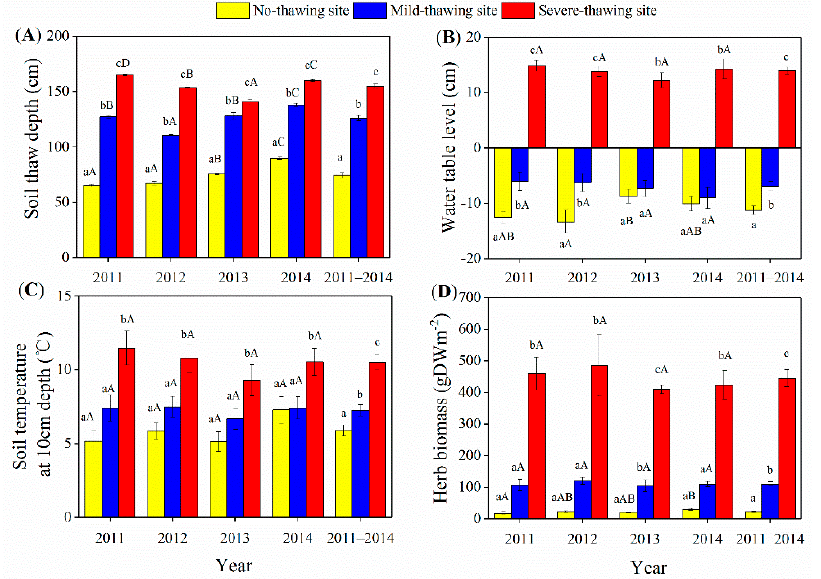
Figure 3. Differences in soil thaw depth ( A ), water table level ( B ), soil temperature ( C ) and herb biomass ( D ) among sampling years and sites. Data are means ± SE. For water table level and soil temperature, n = 18 in 2011, n = 16 in 2012, and n = 17 in 2013 and 2014. For soil thaw depth, n = 10 in each year. For herb biomass, n = 3 in each year. Different lowercase letters indicate the significant differences among sites in the same year or the mean of the four years. Different capital letters indicate the significant differences in the same site between different